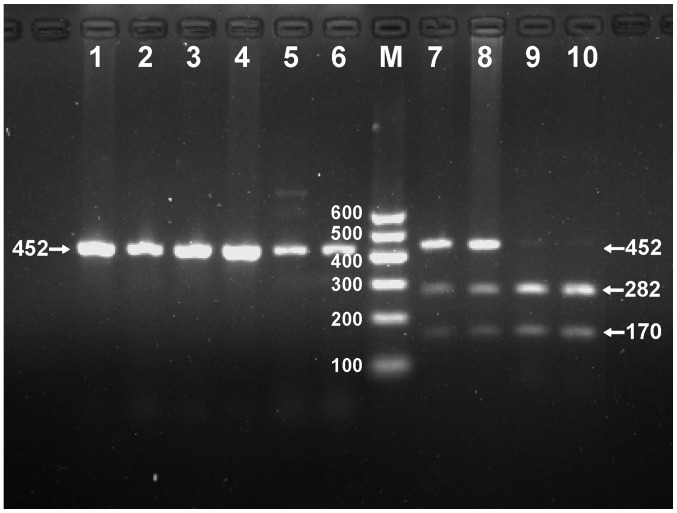
Genotyping of the rs7134375 single nucleotide polymorphism in the phosphodiesterase 3A gene. Lane M, 100 bp marker ladder; lanes 1–4, PCR products (452 bp); lanes 5 and 6, AA genotype (452 bp); lanes 7 and 8, AC genotype (452, 282 and 170 bp), and lanes 9 and 10, CC genotype (282 and 170 bp).